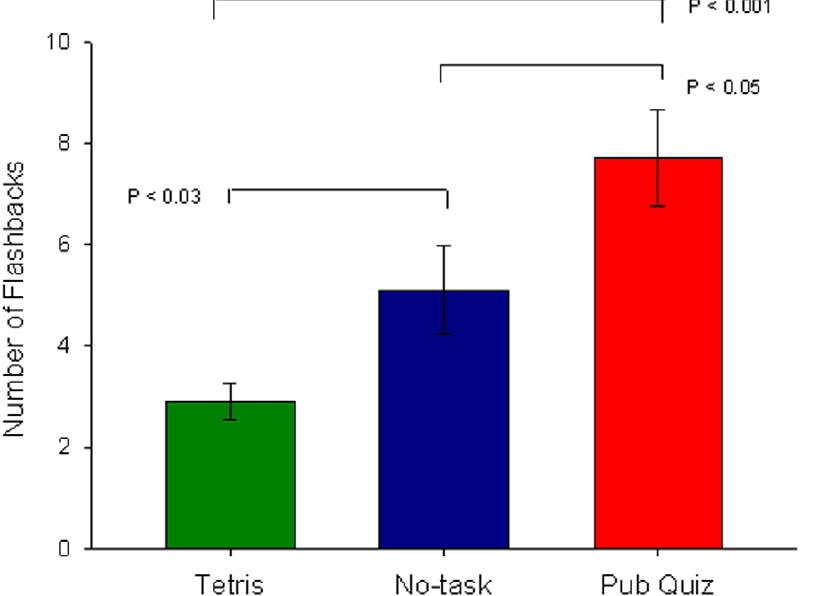
Figure 2. Experiment 1 key outcome variable: flashback frequency in diary over 1-week for the three conditions (mean + / 2 sem). doi:10.1371/journal.pone.0013706.g002 PLoS ONE |